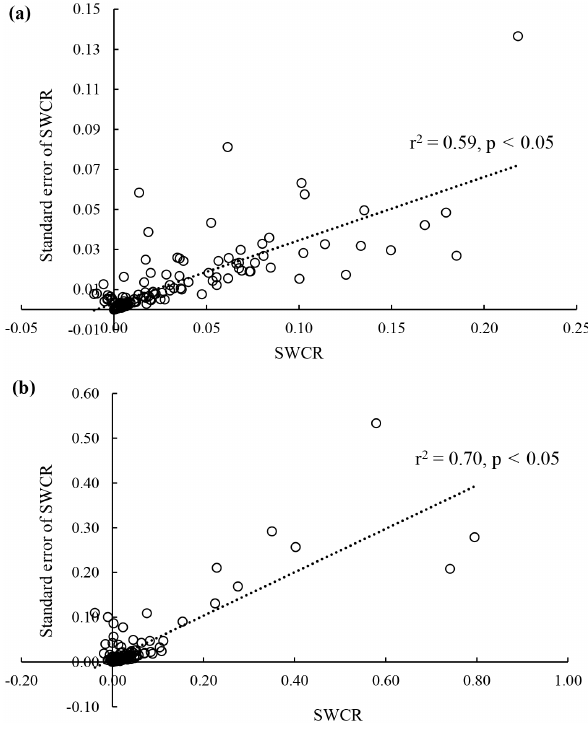
Figure 3. Standard errors of the Surface Water Climate Re- sponse (SWCR) tended to be positively correlated with both (a) dis- continuous surface water (DCW) or surface water disconnected from the stream network and (b) continuously connected wa- ter (CCW) or surface water connected to the stream